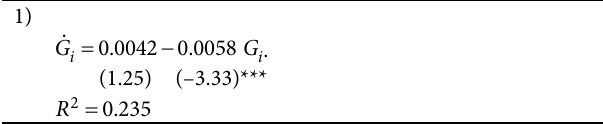
Table 2. Estimation of reduced